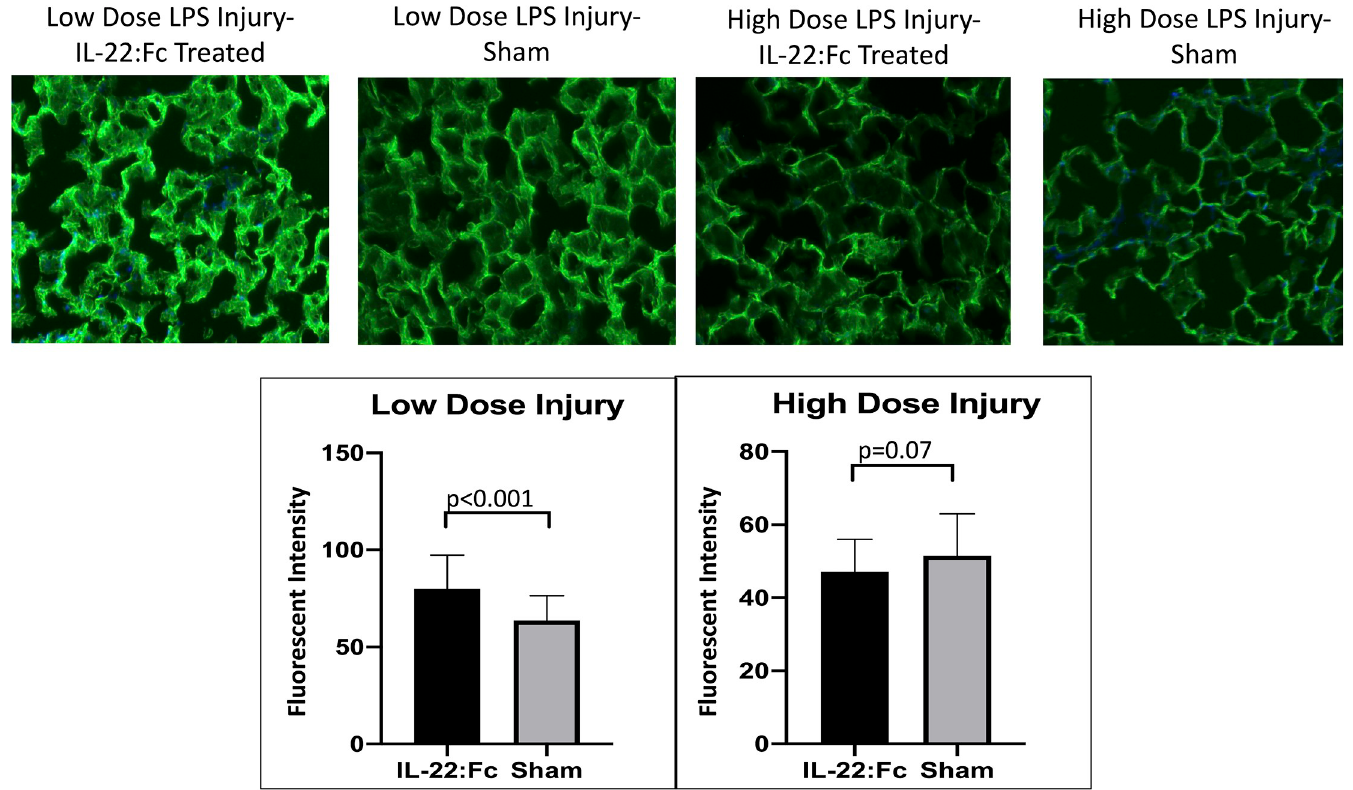
Fig 5. Comparison of endothelial glycocalyx staining intensity. IL-22:Fc treated mice have improved preservation of the endothelial glycocalyx in alveolar capillaries as compared to sham animals. Endothelial glycocalyx staining intensity was increased in the alveolar capillaries in IL-22:Fc treated mice after low-dose LPS injury. Endothelial glycocalyx staining intensity was not different for IL-22:Fc treated mice in high-dose LPS injury.